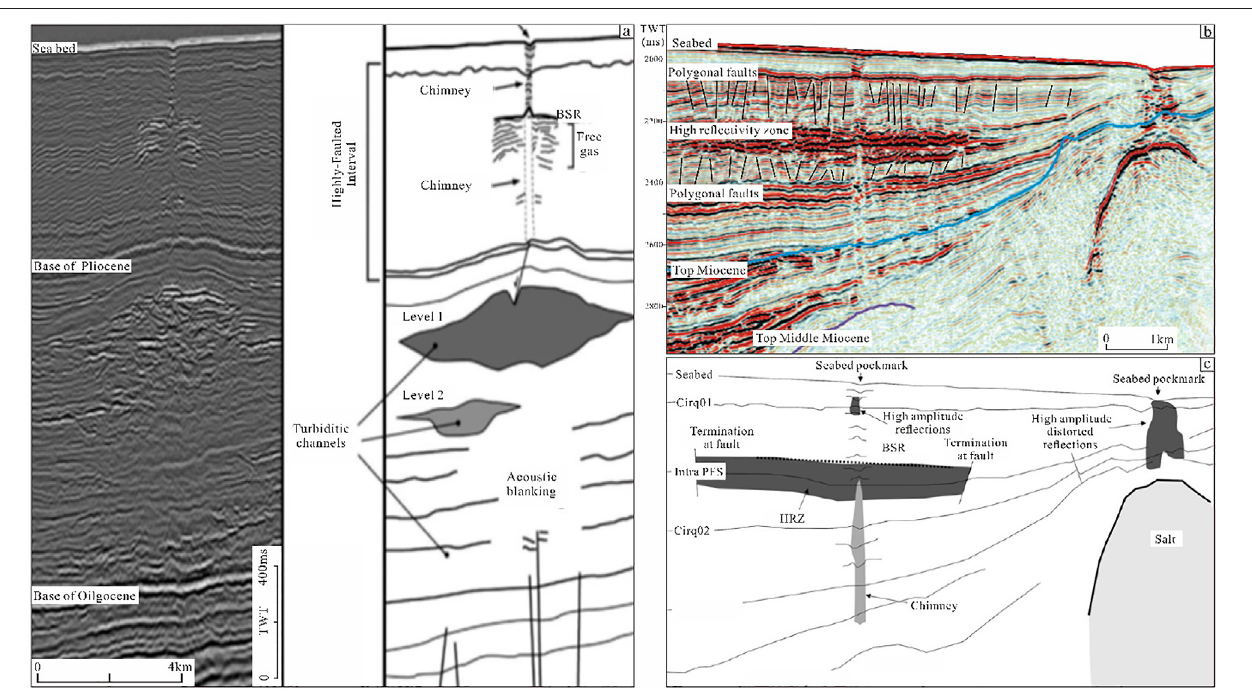
FIGURE8|(A) Aseismicpro fi leanditsinterpretationinnorth-southdirectionacrossasinglepockmarkintheLowerCongoBasin(modi fi edfromGayetal.(2006)). The highly-faulted interval is composed of numerous closely spaced polygonal faults as shown in Figure 8B,C . A seismic pro fi le and its interpretation in southeast direction in the Lower Congo Basin (modi fi ed from Andresen and Huuse